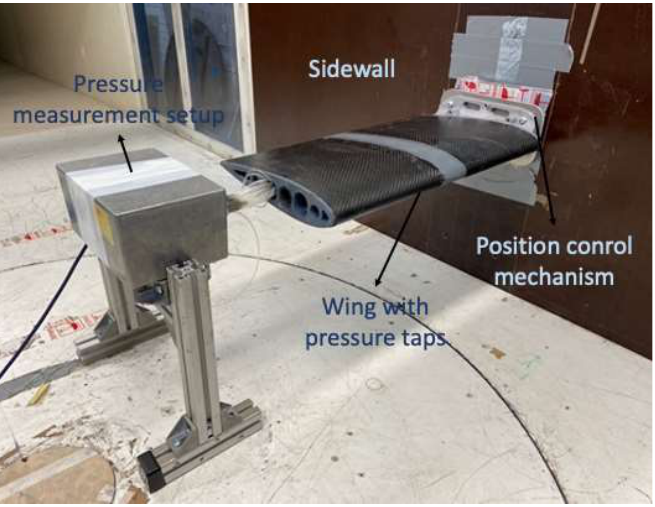
Figure 3. Pressure measurement setup connected to the rubber tubes attached to the wing taps.